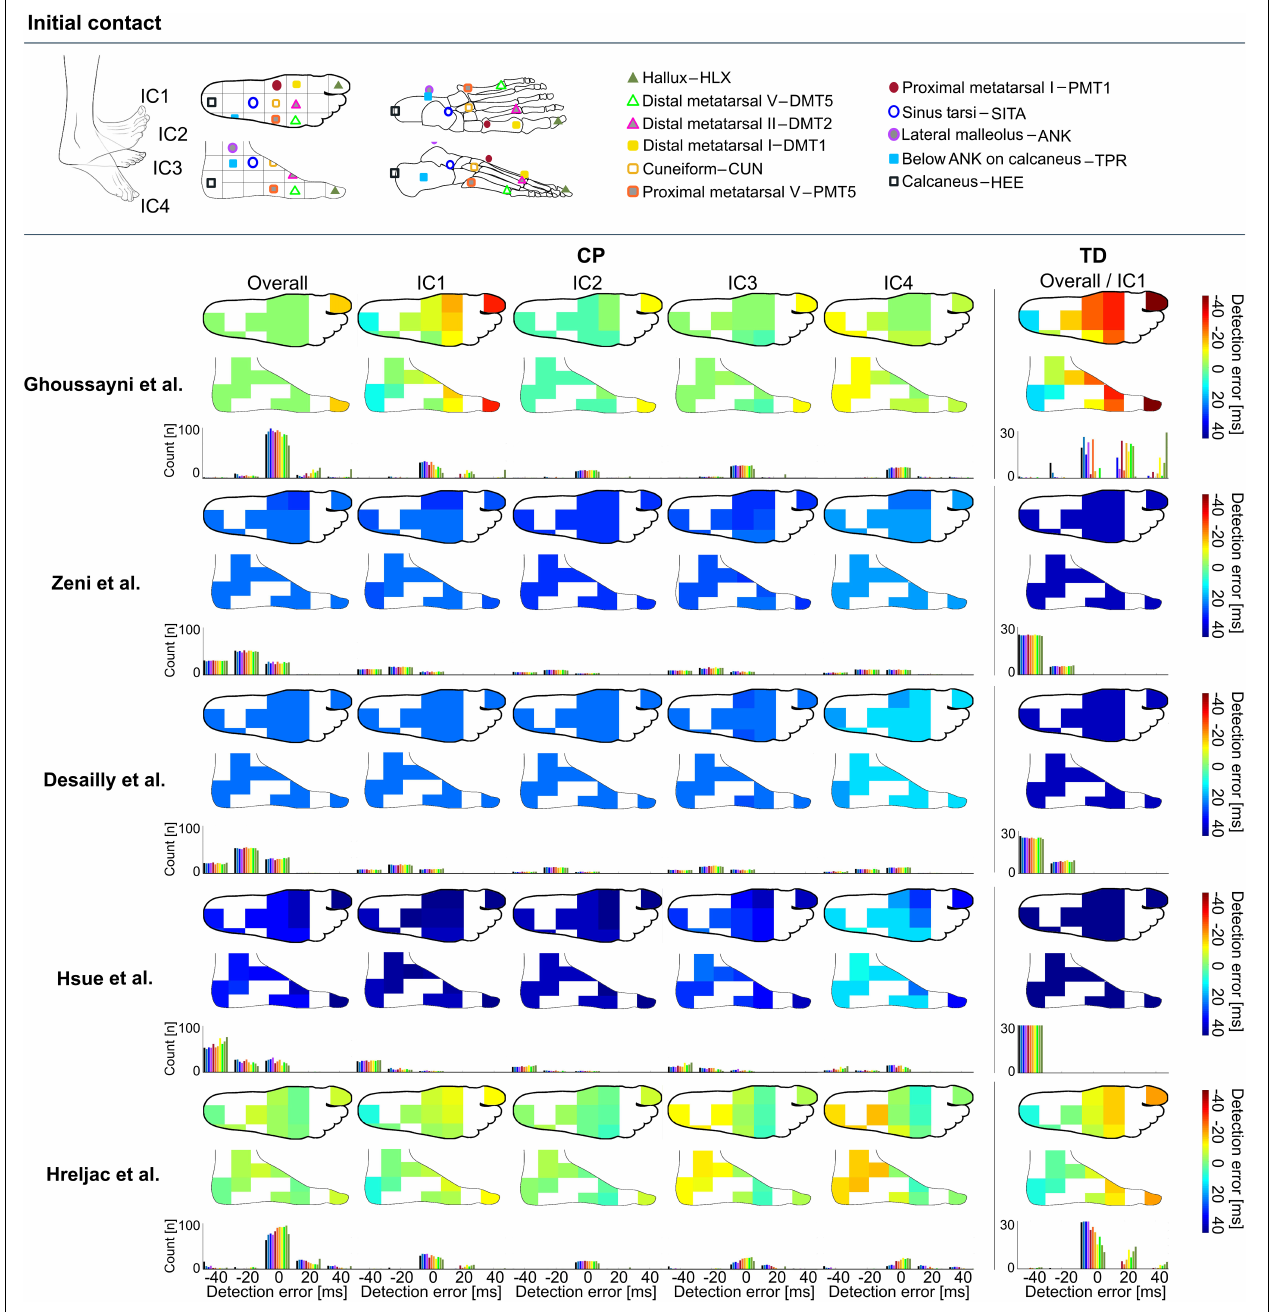
FIGURE 1 | Heatmaps showing median detection errors for estimating the timing of initial contact (IC) for individuals with cerebral palsy (CP) and typical development (TD) per selected marker and method. The location of the markers is indicated on top of the figure, each marker location is connected to a pixel on the heatmap. The color of the heatmap indicates the median detection error. The histogram below each heatmap indicates the number of individuals for which a certain detection error was obtained. Groups IC1–IC4 were based on angle of the foot in the sagittal plane during midstance, Supplementary Table 1